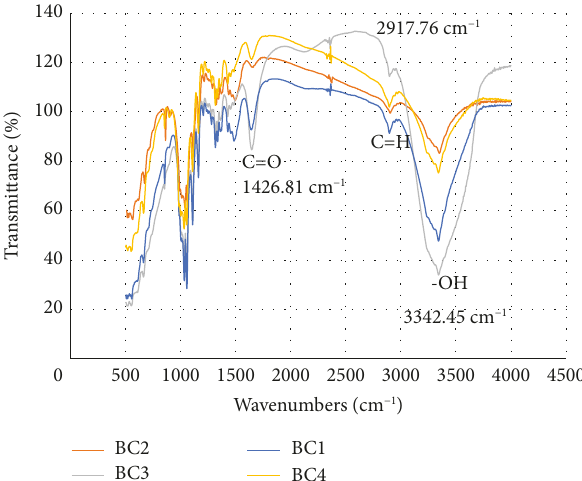
Figure 7: FTIR of bacterial cellulosic membranes under various sonication times: BC1—15min, BC2—30min, BC3—60min, BC4—90min.